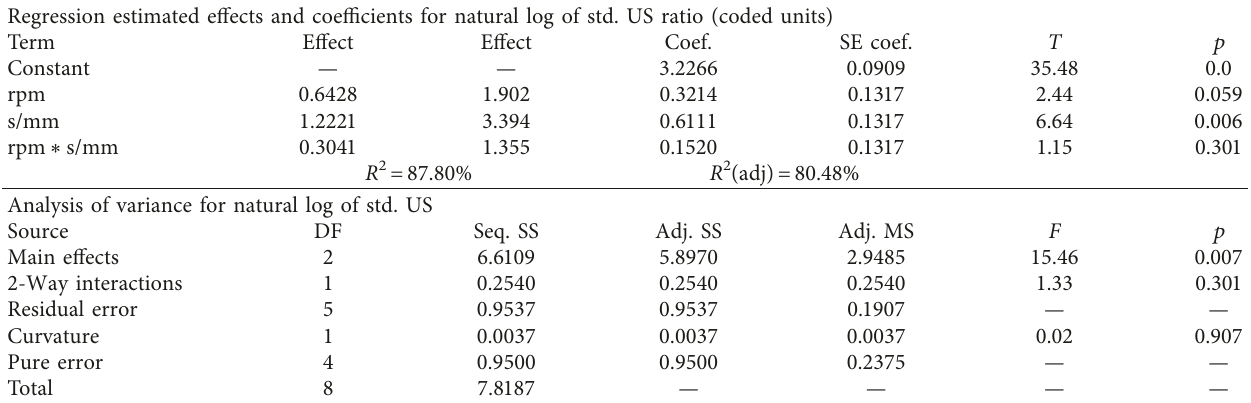
Table 6: Results of ultimate strength analysis of variability.